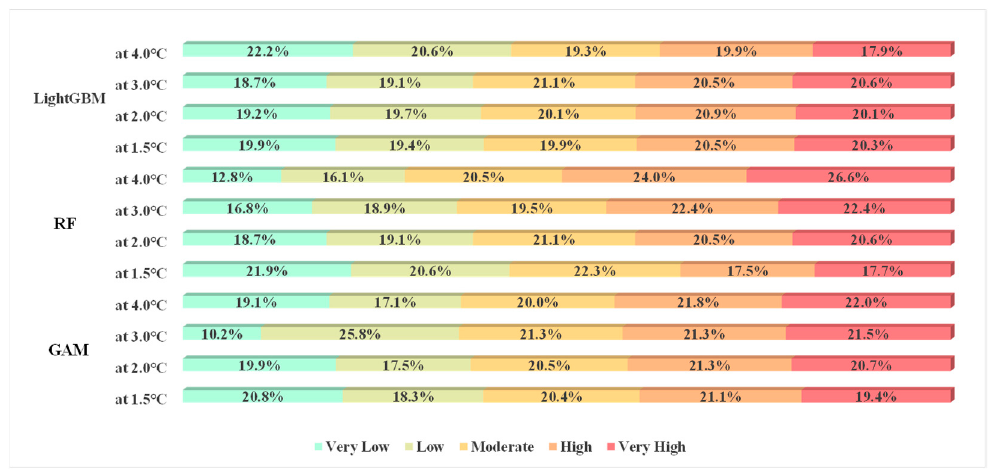
Figure 9. Percentage of different landslide susceptibility classes under different warming scenarios.